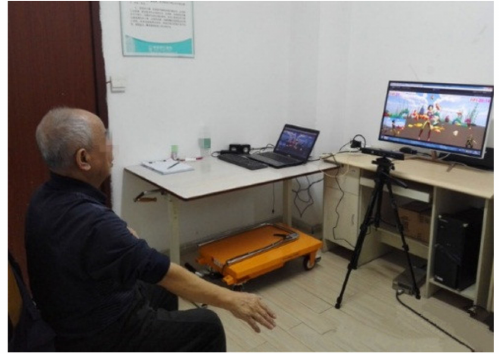
Figure 8. Rehabilitation scene in Nanjing Tongren hospital.